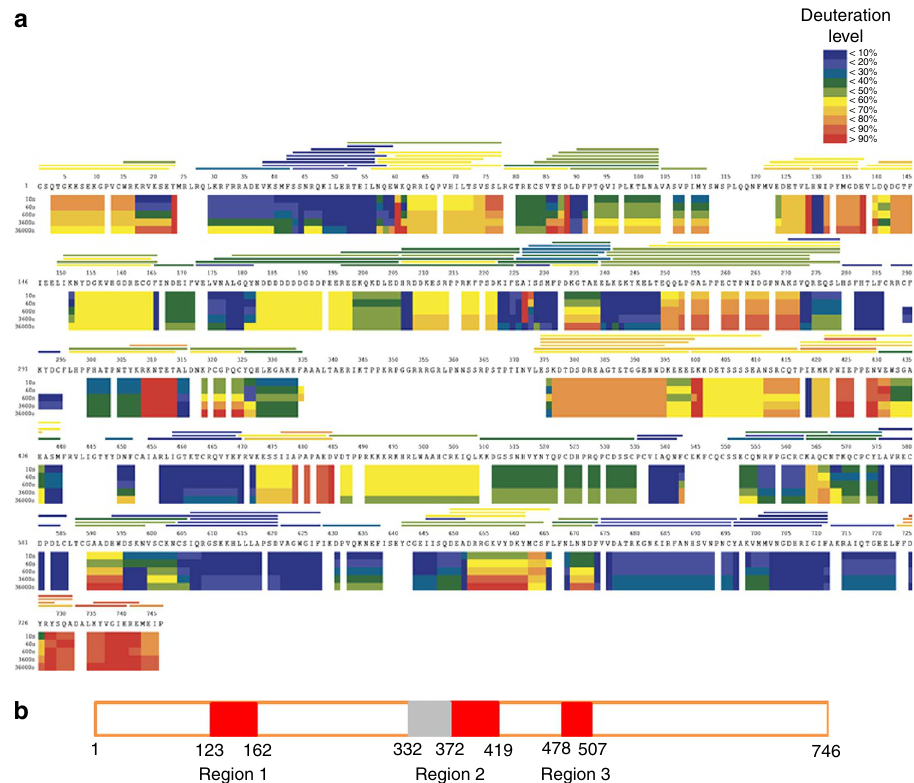
Figure 1 | Dynamics of Hs EZH2 in the context of five-protein Hs PRC2. ( a ) HDX-MS ‘heat map’ represents the solution dynamics of full-length Hs EZH2: red regions indicate protein exposed to solvent and readily available for backbone exchange. Blue regions are blocked from exchange because they are: (1) buried in protein (2) involved in hydrogen bonding (secondary structure) or (3) blocked by protein–protein interactions. The horizontal bars at the top of the heat map represent average deuteration for each of the 147 individual peptides (90% sequence coverage) monitored during the experiments performed in triplicate. ( b ) HDX-derived dynamic ‘hot regions’ (red) of Hs EZH2. Homologous dynamic and ‘no coverage’ (grey) regions in both Hs EZH2 and Ac EZH2 were explored with internal